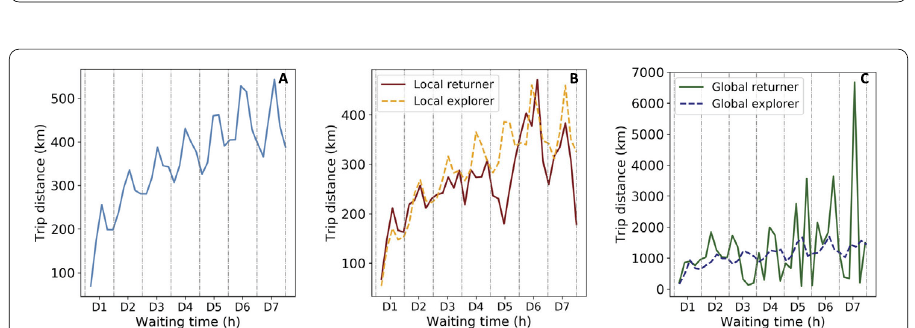
Figure 8 The complementary cumulative distribution function (cCDF) of trip distance. ( A ) Domestic trips validated against the one-day travel survey. ( B ) International trips validated against the 60-day long-distance/international travel survey